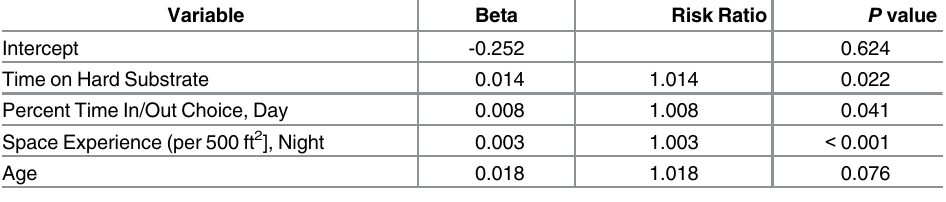
Table 9. Multivariable assessment of possible persistent foot scores using Poisson regression.